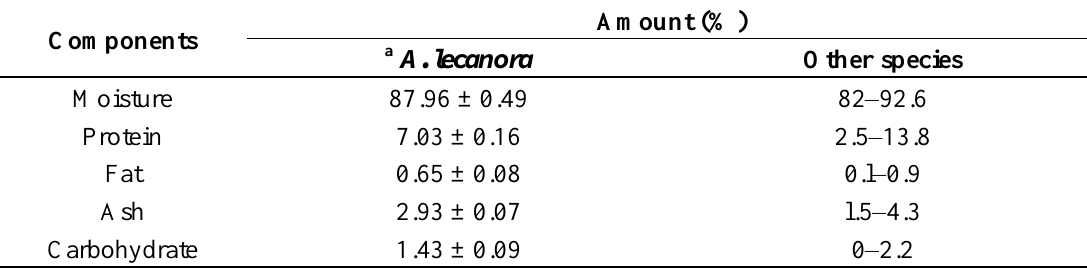
Table 1. Proximate compositions of fresh A. lecanora (wet weight basis %) in comparison to other